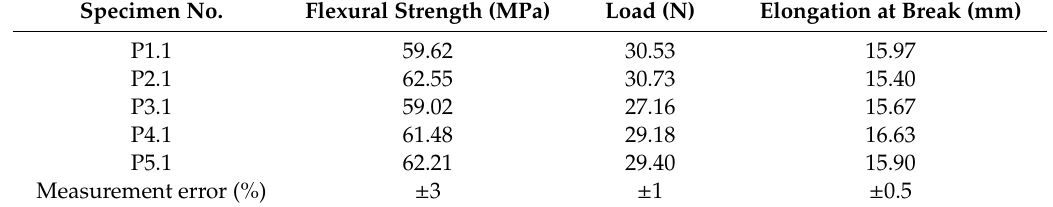
Table 6. Flexural tests for specimens cured at 80 °C for 2 h.